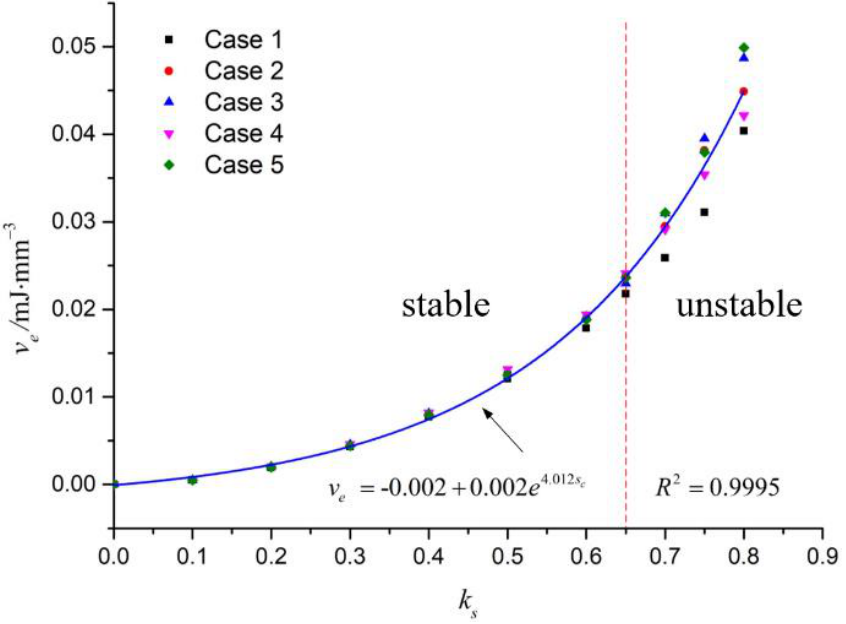
Figure 11. v e evolution curves with k s increasing.